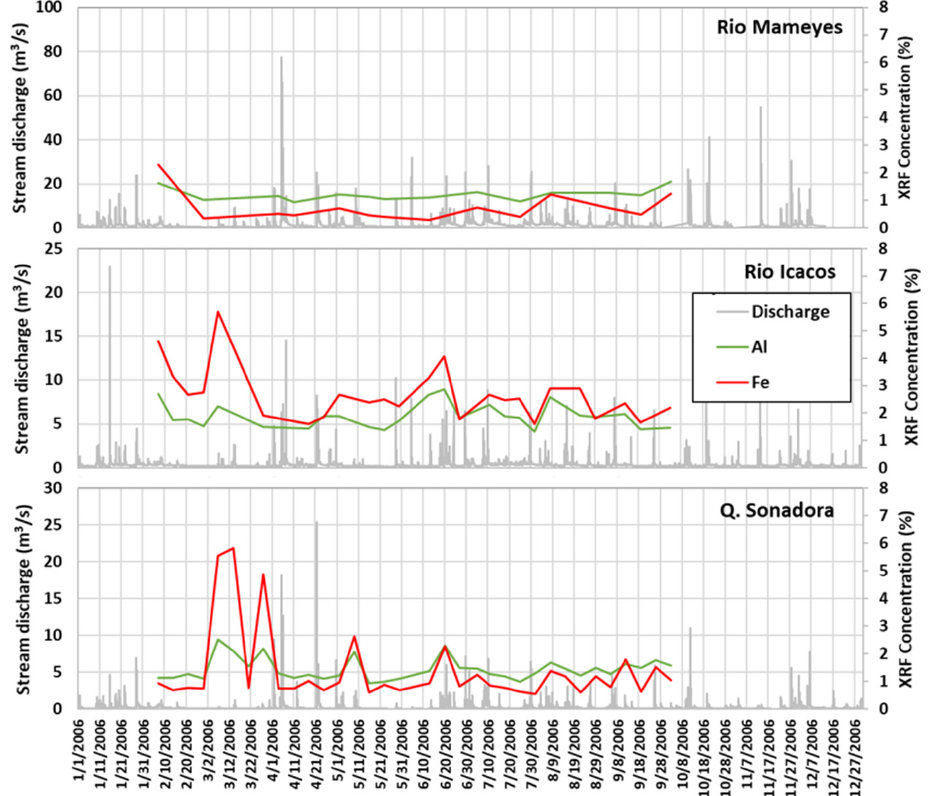
Figure 5. River discharge and concentrations from XRF analysis in percent of Al and Fe of suspended sediments collected on filters.